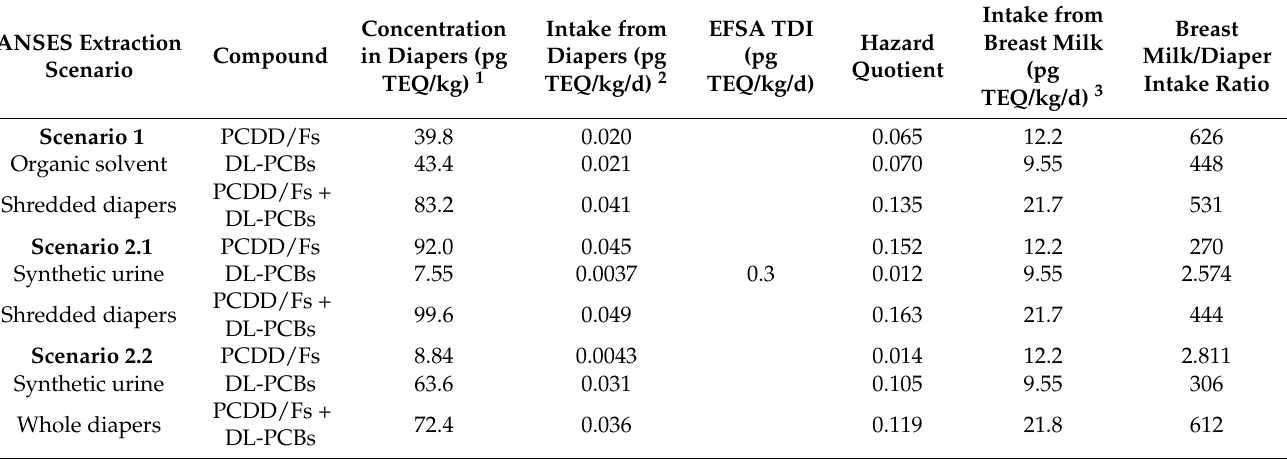
Table 3. Risk assessment of dioxins (PCDD/Fs) and DL-PCBs in diapers with the scenario